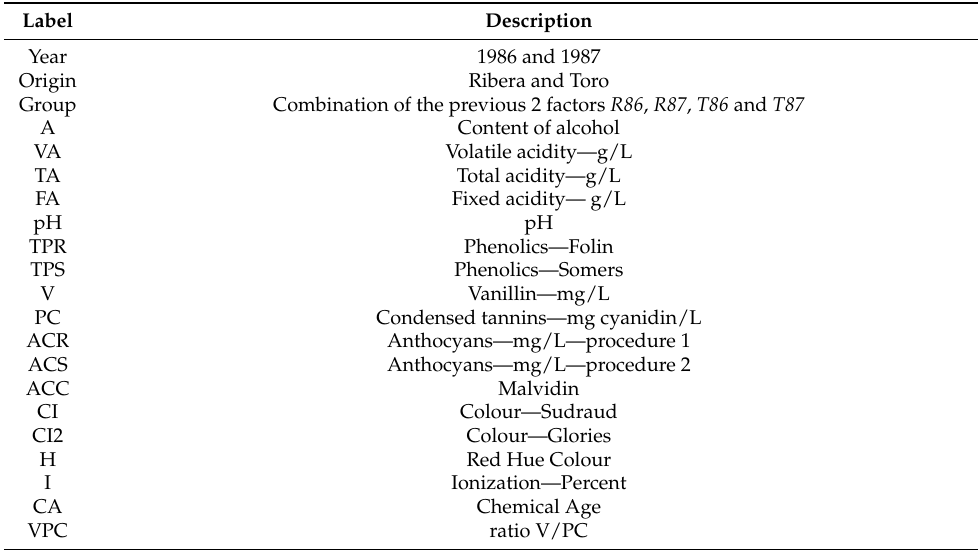
Table 1. Description of the